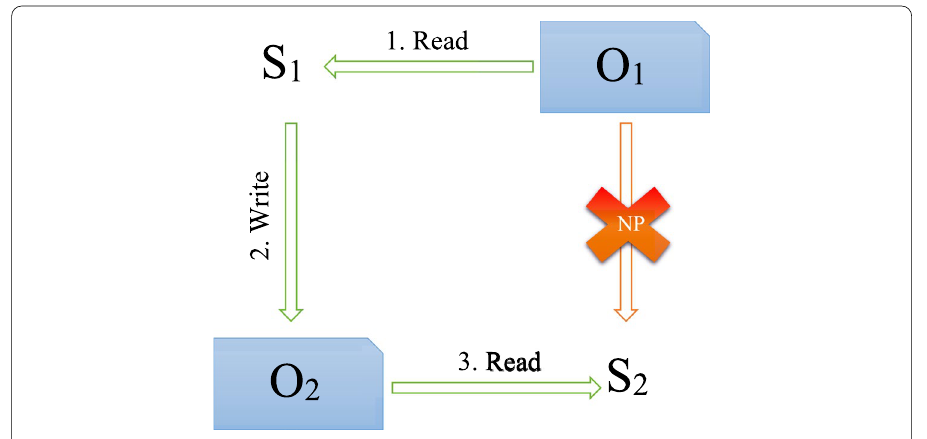
Fig. 2 Schematic description for an implicit violation of security policy example